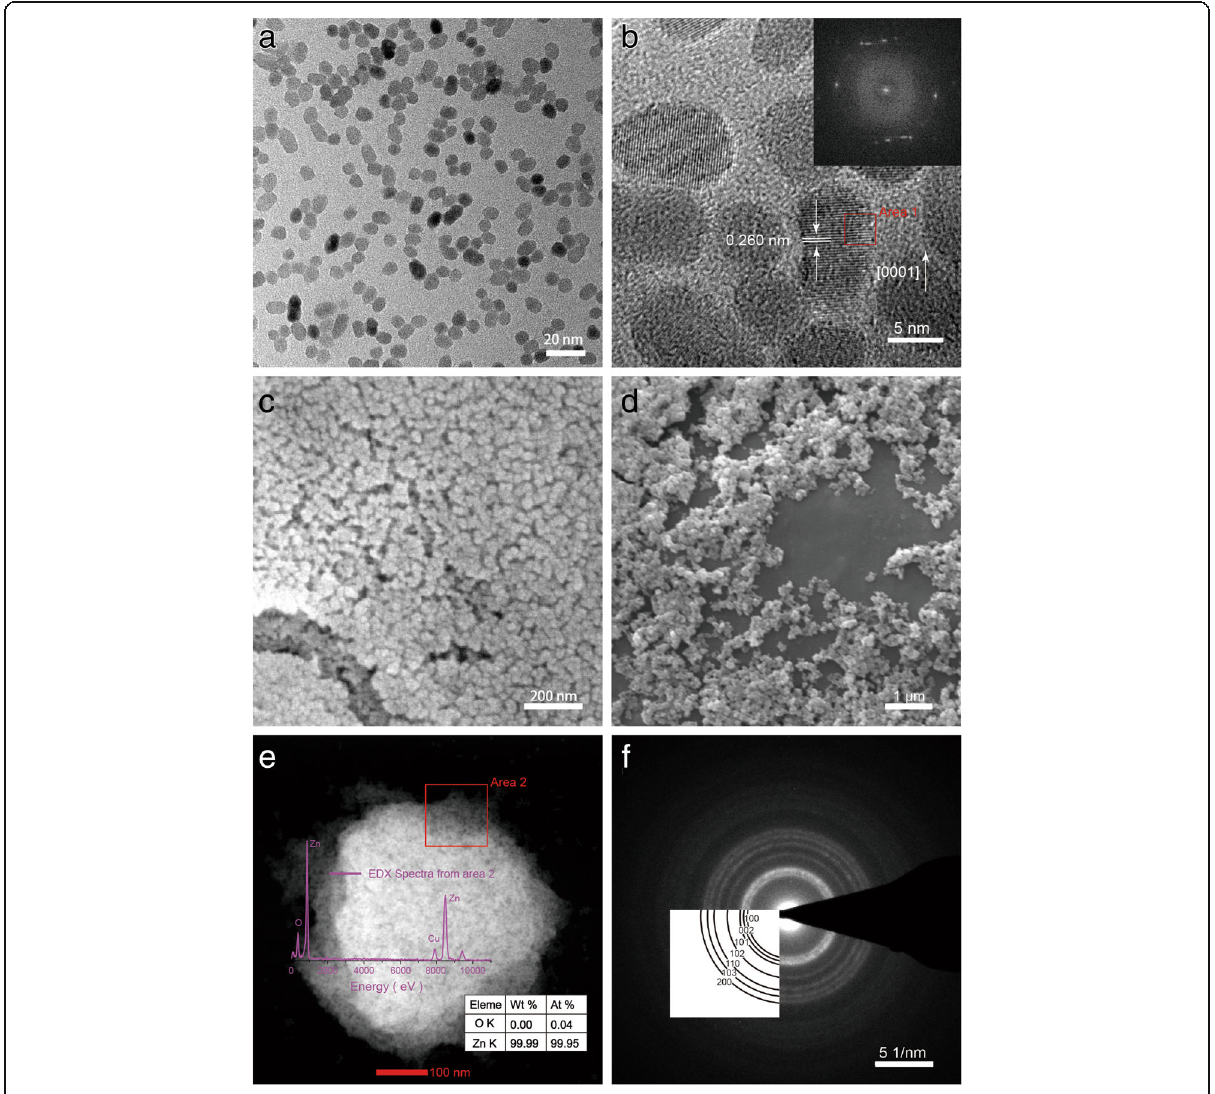
Fig. 3 TEM, SEM, EDX, and SAED results for ZnO NPs from sample 4. a , b Low- and high-magnification TEM images showing bulk morphology of the sample and lattice fringes, respectively. b Fourier filtered image from area 1. c , d SEM images of well-dispersed particles. e SEM image of the particle used to record EDX spectrum from area 2. f SAED pattern shows wurtzite